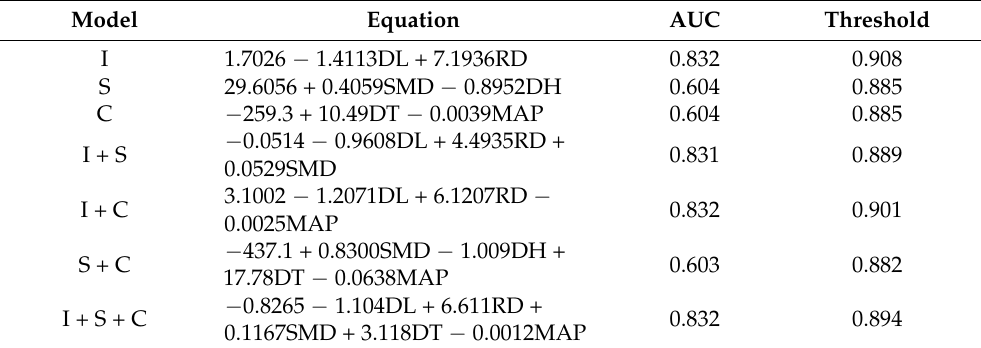
Table 3. Model comparison and selection; AUC area under receiver operating characteristic.